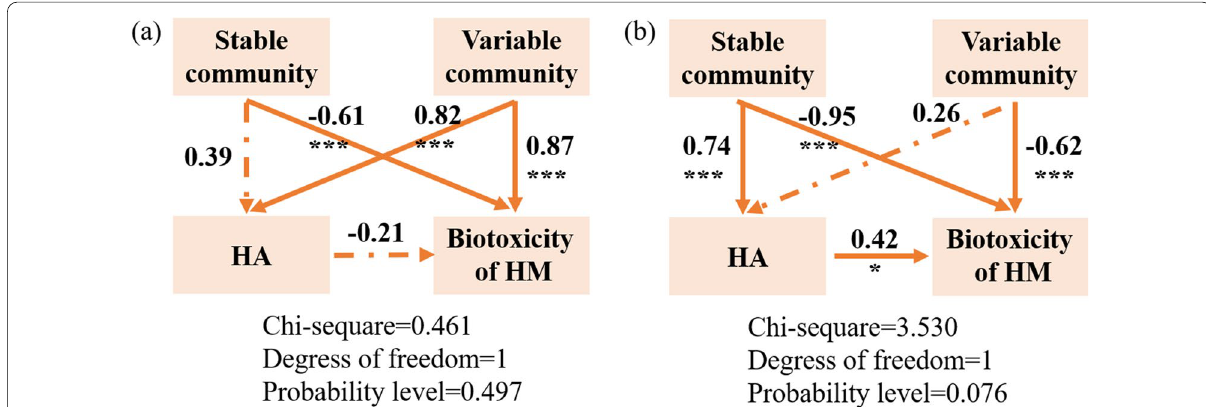
Fig. 6 The structural equation models of CK composting ( a ) and treatment group composting ( b ), which represented the hypothesized causal relationships among different microbial groups, HA content and the bioavailable fractions of heavy metals. Arrows descript the casual relationship (solid: significant relationship; dotted: nonsignificant relationship. Numbers adjacent to arrow represent path coefficients. Significance level is descripted: *0.01 < P < 0.05, **0.001 < P < 0.01, *** P < 0.001. HA humic acid, biotoxicity of HM biotoxicity of heavy